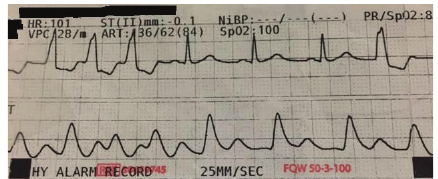
Figure 3: EKG strip showing ventricular